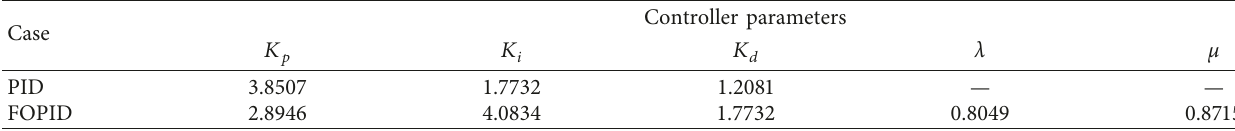
Figure 9: Convergence curves of objective function with Δ f � − 0 . 5Hz. Table 9: The optimized controller parameters with Δ f � − 0 . 5Hz.